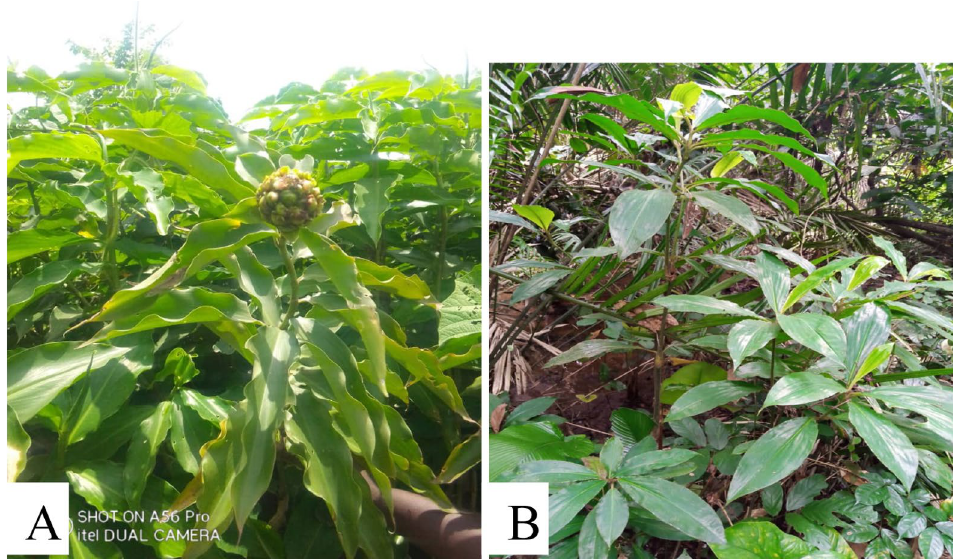
Fig. 1 Habit photograph of A Costus afer and B Palisota hirsuta Habit photograph shows some macroscopic features of the plant samples which include shape of leaf apex, leaf colour, leaf arrangement and so on